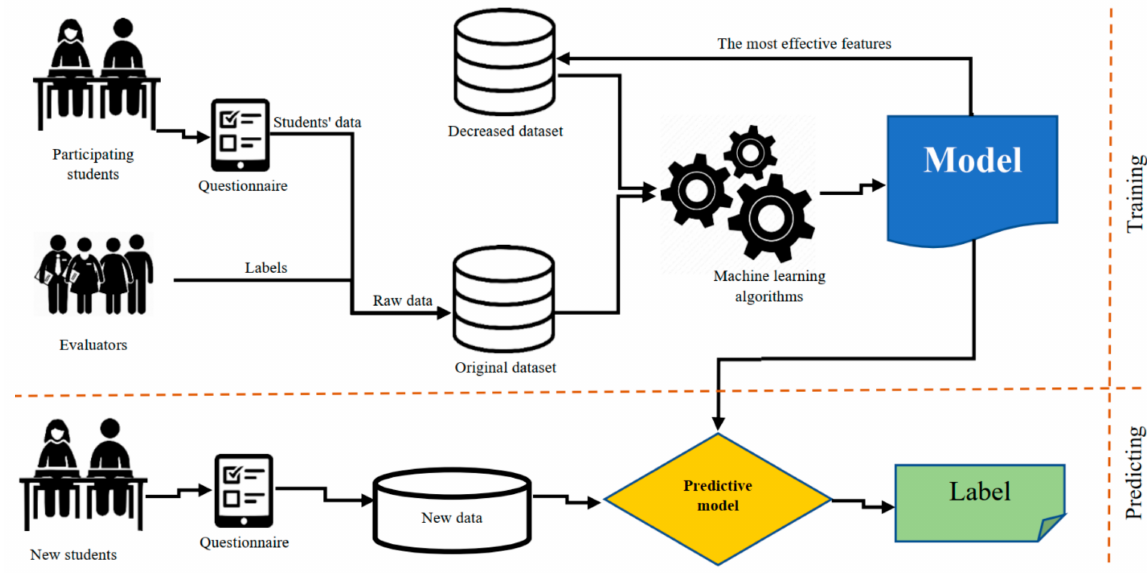
Figure 1. An overview of the research